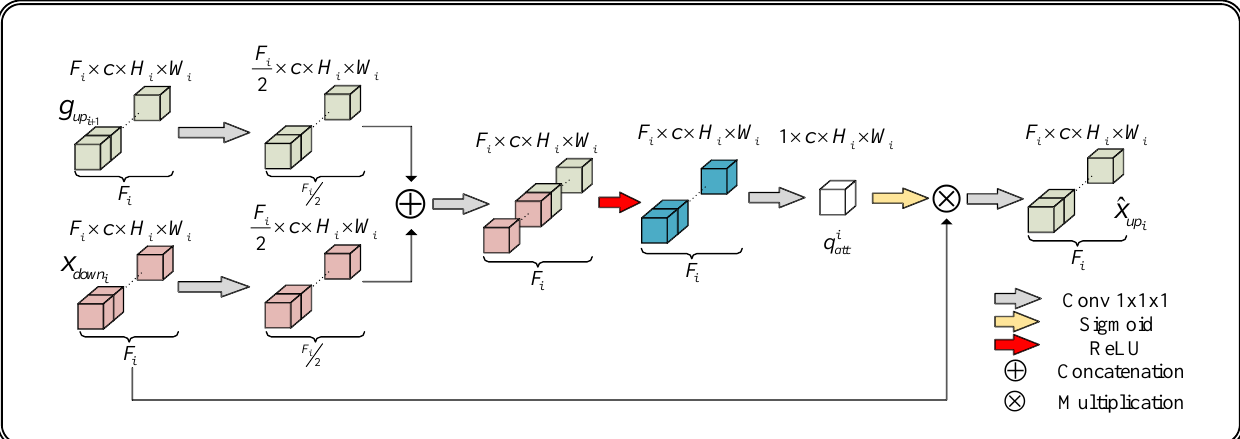
Figure 3. The attention gate (AG)